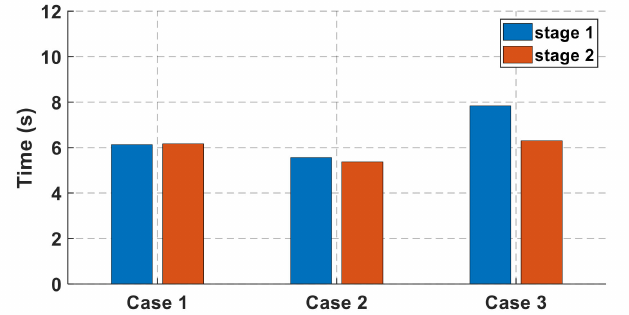
Figure 7. Computational time of simulated cases.